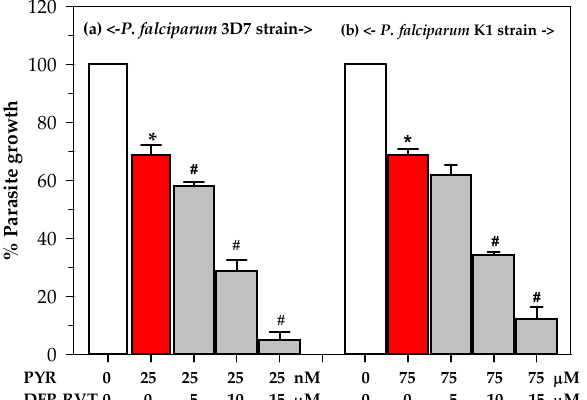
Figure 5. Inhibitory effects of combined PYR and DFP-RVT treatments on the growth of P. falciparum 3D7 strain ( a ) and K1 strain ( b ). Data obtained from three repetitive experiments are expressed as mean ± SD values. * p < 0.05 when compared without treatment; # p < 0.05 when compared with 25 nM PYR treatment for the 3D7 strain and 75 M for the K1 strain alone.